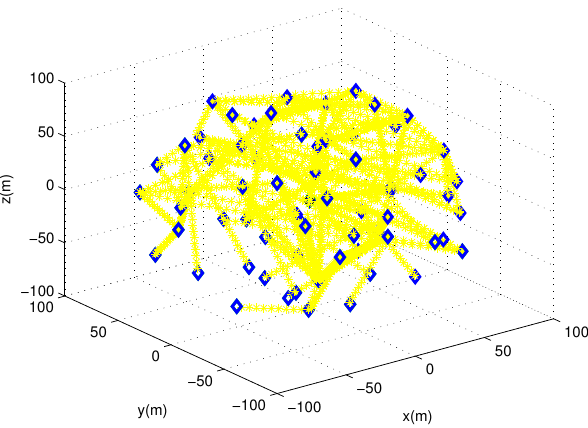
Figure 2. The path of each maneuvering AR until the user-specified 3D shape (sphere with radius 100) is entirely covered ( r sc = 50 m). The path of a maneuvering AR is depicted with yellow line segments. The final position of a maneuvering AR is depicted as a blue diamond. See that blue diamonds are marked at the end points of each line